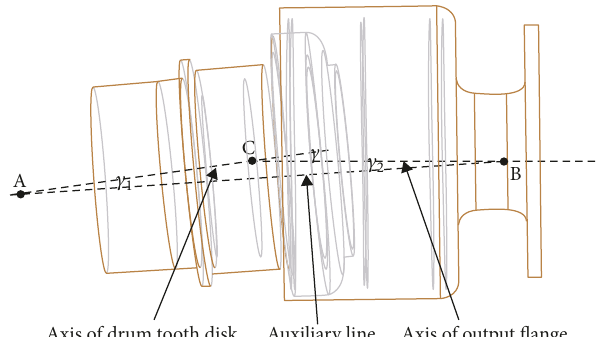
Figure 10: Schematic diagram of the angle between the drum tooth disk and the axis of the output